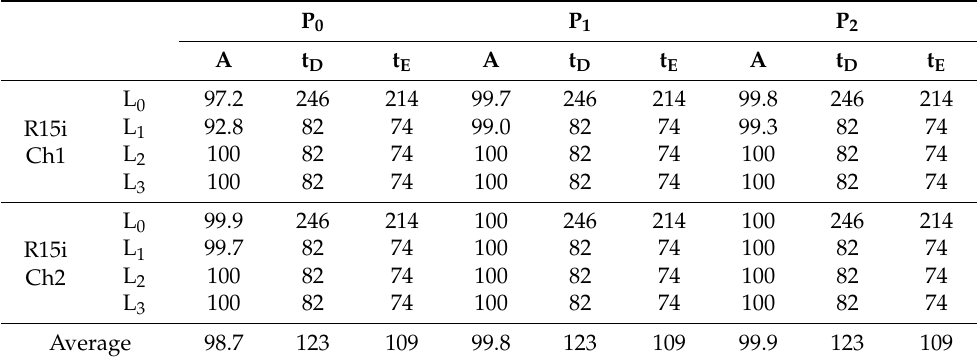
Figure 9. Confusion matrices resulting from experimental scenarios: R15i Ch1 ( a ) P 0 , ( b ) P 1 , ( c ) P 2 ; R15i Ch2 ( d ) P 0 , ( e ) P 1 , ( f ) P 2 (classes 0, 1, 2, 3, and 4 are L 0 , L 1 , L 2 , and L 3 , respectively). Table 4. Classification accuracy and execution time.